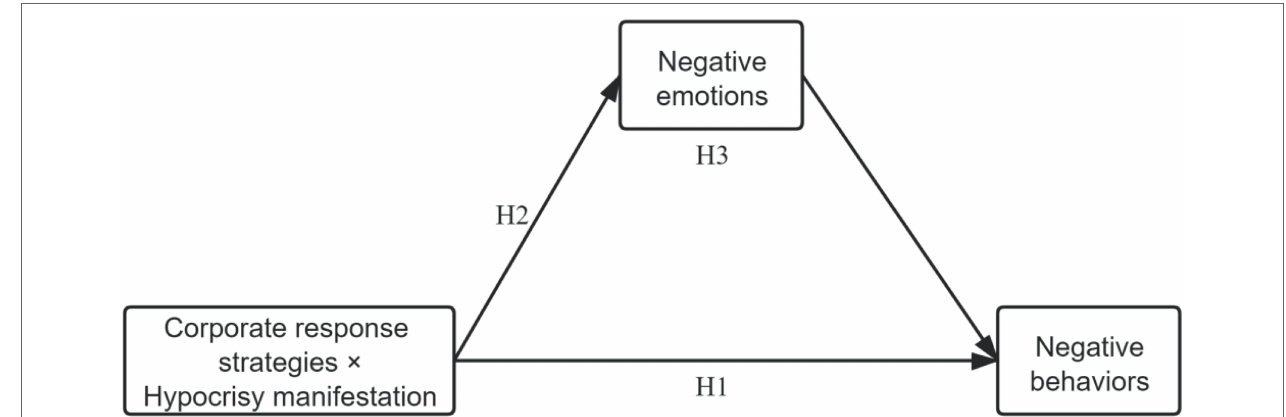
FIGURE 1 | Conceptual model of this